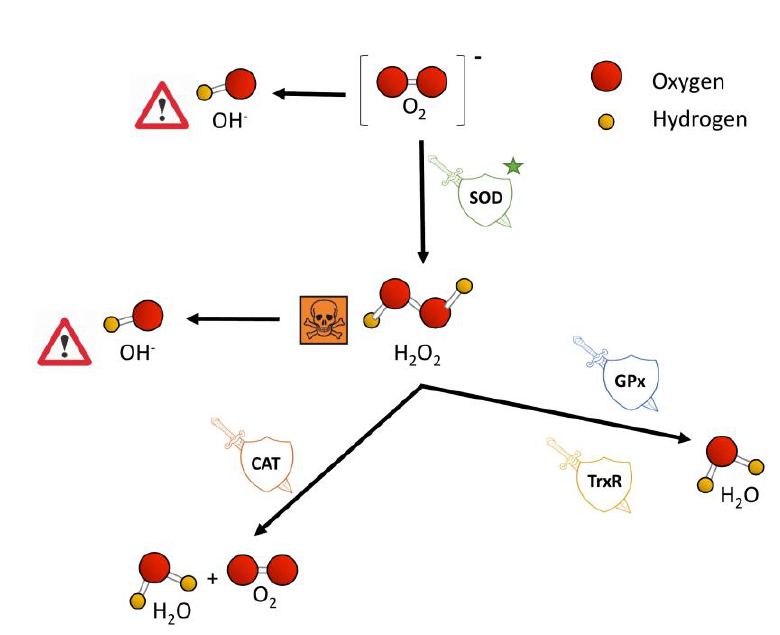
FIGURE 2: Toxic ROS generation and enzy- matic antioxidant defenses. Cells encompass a group of enzymes which help counterbal- ancing the potential detrimental effects of ROS production upon toxic levels. O 2- ,